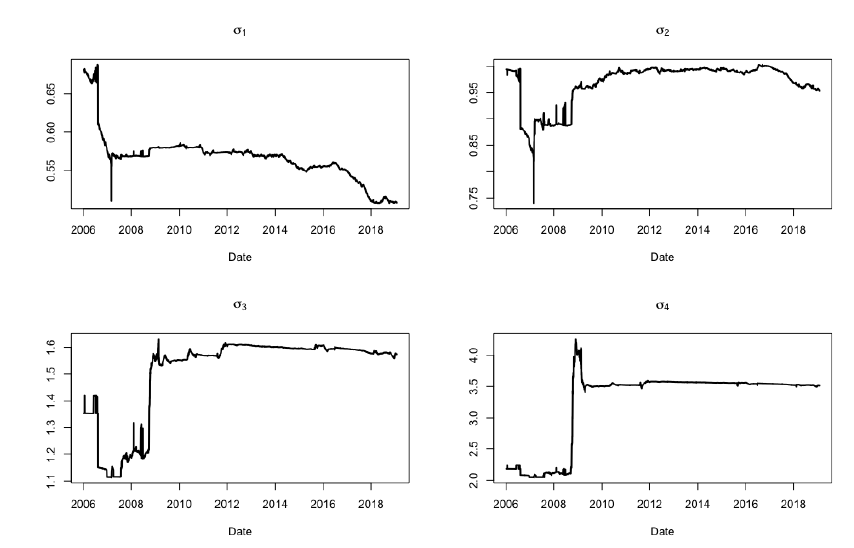
Figure 12. Expanding window: state-dependent means and volatilities for the homogeneous four-state normal HMM on S and P 500 daily log returns.